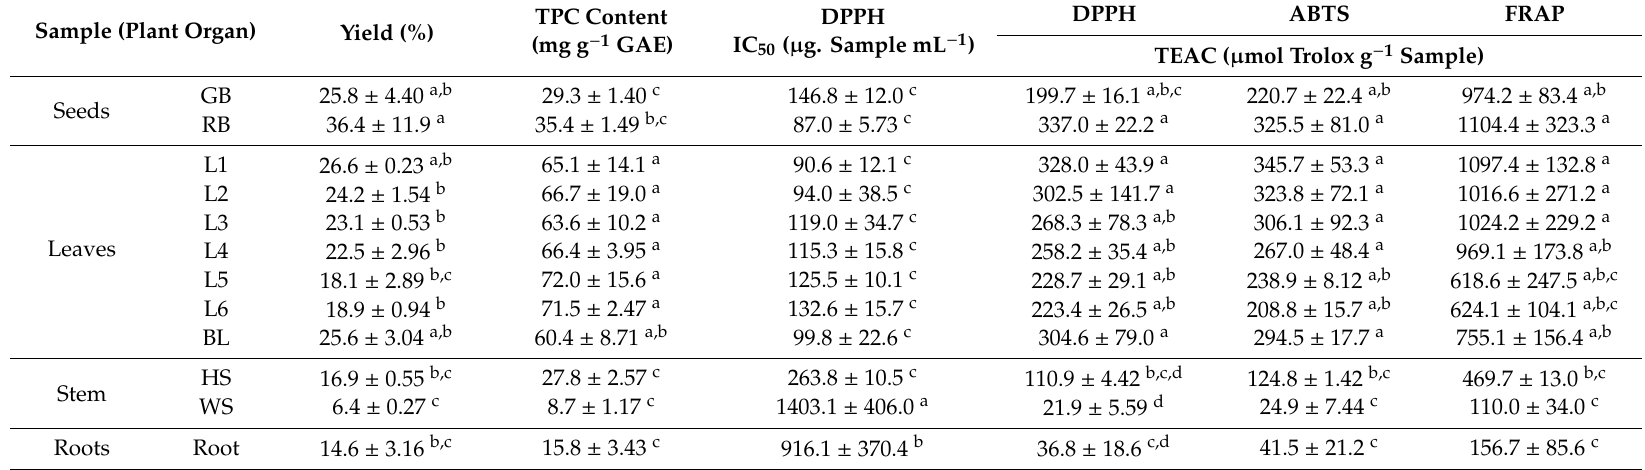
Table 4. Total phenolic content (TPC) and antioxidant capacity of the co ff ee plant